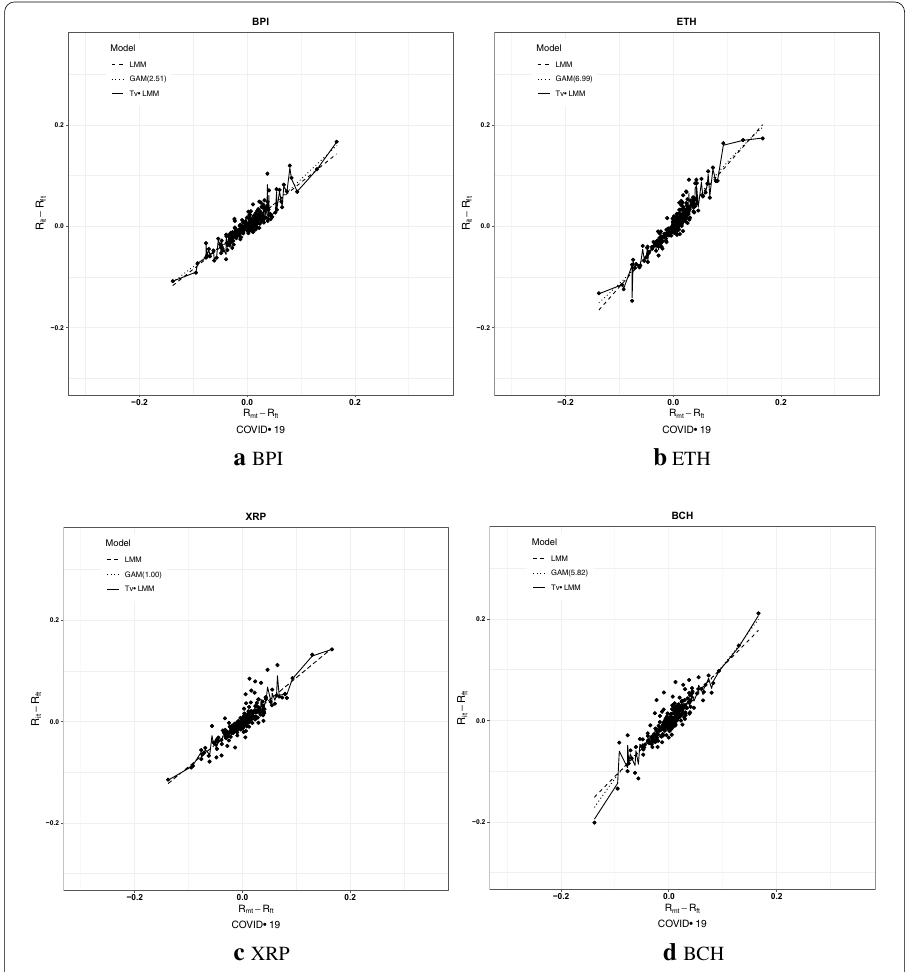
Fig. 4 The scatter plots of the four cryptocurrencies’ daily excess returns in the COVID-19